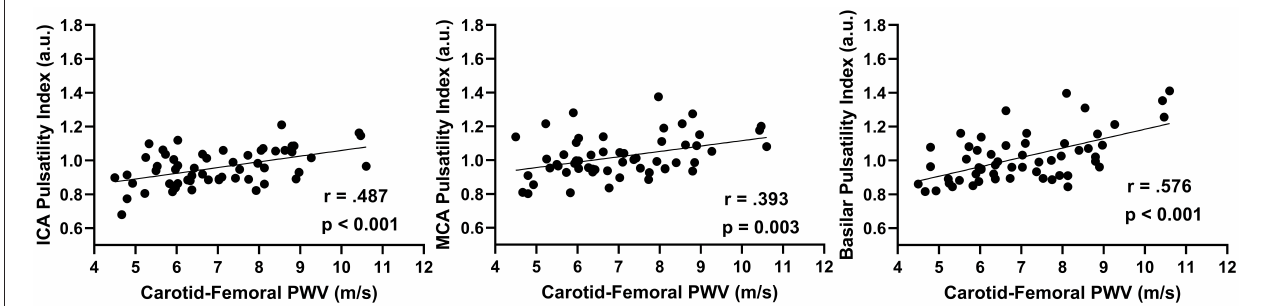
FIGURE 1 | The relationship between internal carotid artery (ICAs), middle cerebral artery (MCAs), and basilar artery pulsatility index with aortic stiffness (cfPWV) in combined age groups ( N = 56) using Pearson correlations.